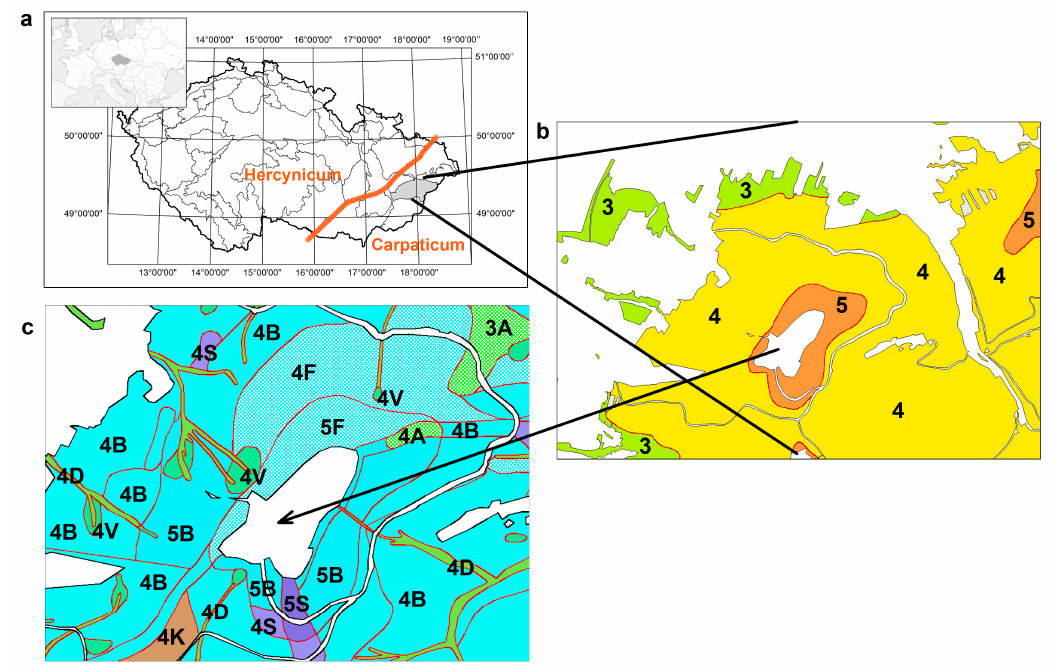
Figure 1. The level scheme of the Czech Forest Ecosystem Classification. ( a ) Distribution of Natural Forest Areas (NFAs) within the Czech Republic. The NFA No 41 within the Carpaticum phytogeographic region is shadowed. ( b ) A map of Forest Vegetation Zones (FVZ). Zooming into the NFA No 41 reveals the FVZs 3–5. ( c ) A classification (forest typological) map. Additional zooming shows the classification map with applied units of the system (Forest Site Complexes [35]) designated by figures (relevant to FVZ) and letters (edaphic categories). The lower units are not shown. Within a zone, an azonal element can appear, e.g., FVZ 3, 4 (Forest Site Complexes 3A, 4A) within the zonal FVZ 4, 5. These azonal sites follow exposed ridges with a skeletal soil. See the Methods for explanation of the system structure.